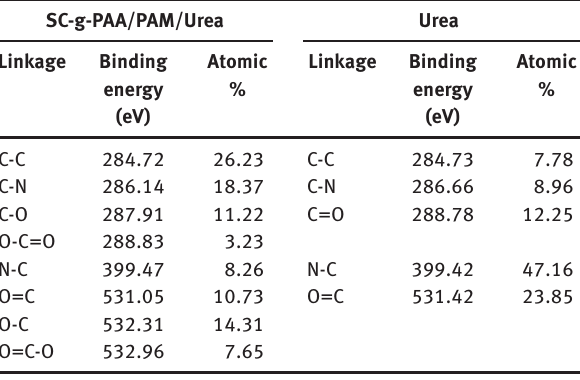
Table 1: XPS analysis of urea and SC-g-PAA/PAM/Urea. SC-g-PAA/PAM/Urea